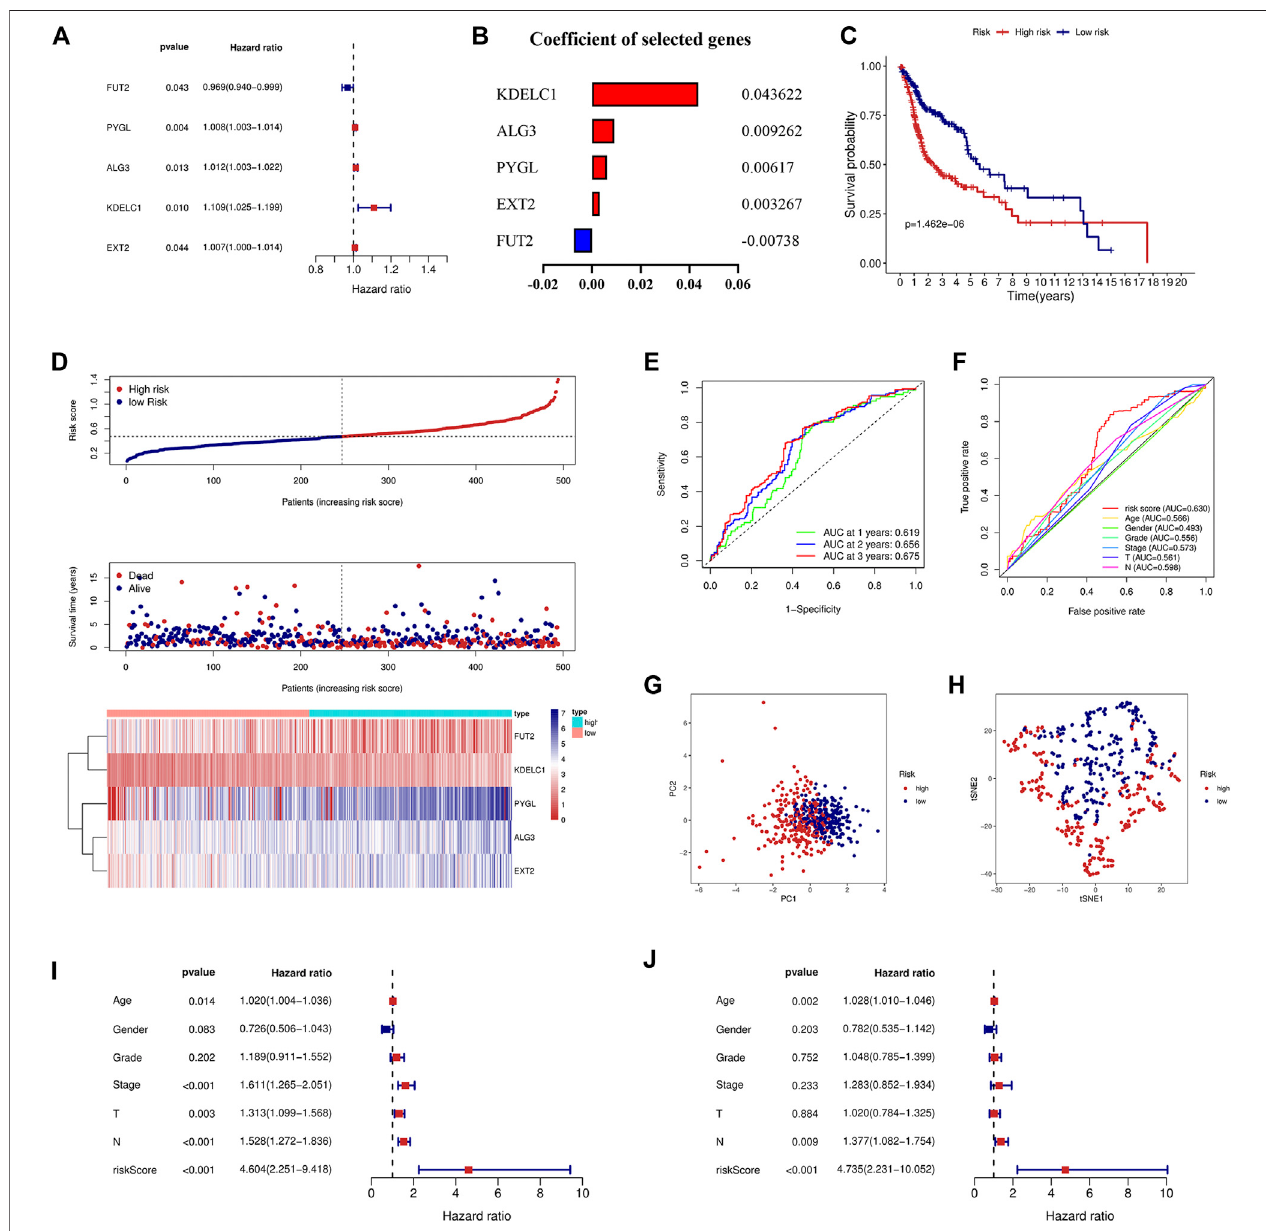
FIGURE 2 | Construction of the prognostic signature based on fi ve GTRGs. (A) Univariate Cox regression analysis identi fi ed fi ve GTRGs associated with the prognosis. Red means risk genes and blue means protective genes. (B) Coef fi cients of the selected fi ve genes in the signature through multivariate Cox analysis. (C) High-risk group had a worse prognosis than the low-risk group through the KM curve and log-rank test. (D) Risk score, survival time, survival status, and the relative expression of fi vegenesbetweenthehigh-andlow-riskgroups. (E) ROCcurveanalysisofthesignatureat1-year,2-year,and3-yearsurvivalinthetrainingcohort. (F) ROC curve analysis of the signature and the other clinical parameters in the training cohort. (G) PCA in the training cohort. (H) tSNE analysis in the training cohort. (I) Univariate Cox analysis of the signature and the other clinical parameters. (J) Identi fi cation of risk score as an independent risk factor for HNSCC patients through multivariate Cox analysis in the training cohort. KM, Kaplan – Meier; ROC, receiver operating characteristic; PCA, principal component analysis; tSNE, t-distributed stochastic neighbor embedding.